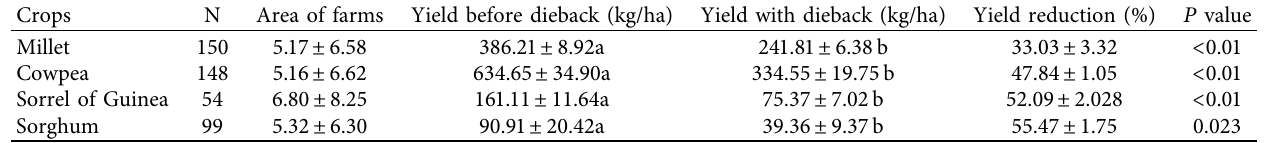
Table 2: The effects of F. albida trees dieback on grain yields of main